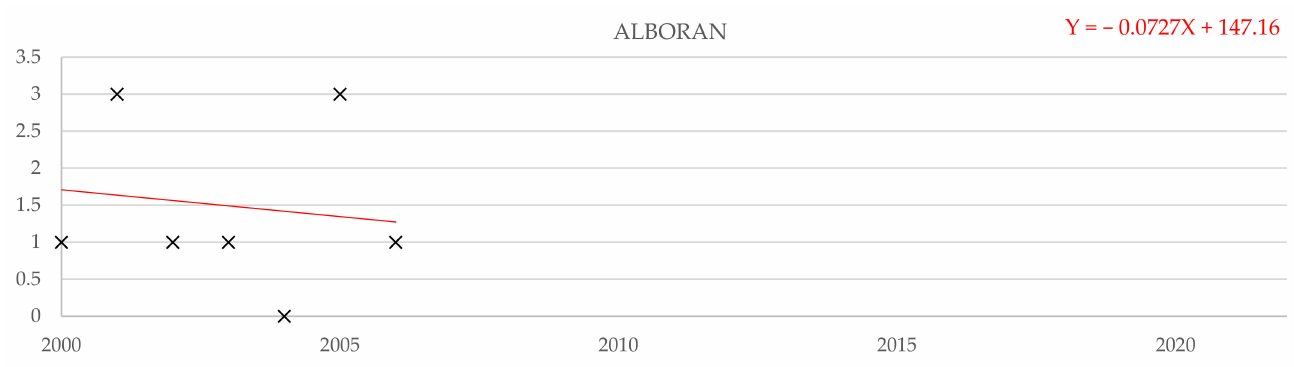
Figure 28. Number of times Tp has exceeded the expected Tp in 100 years in